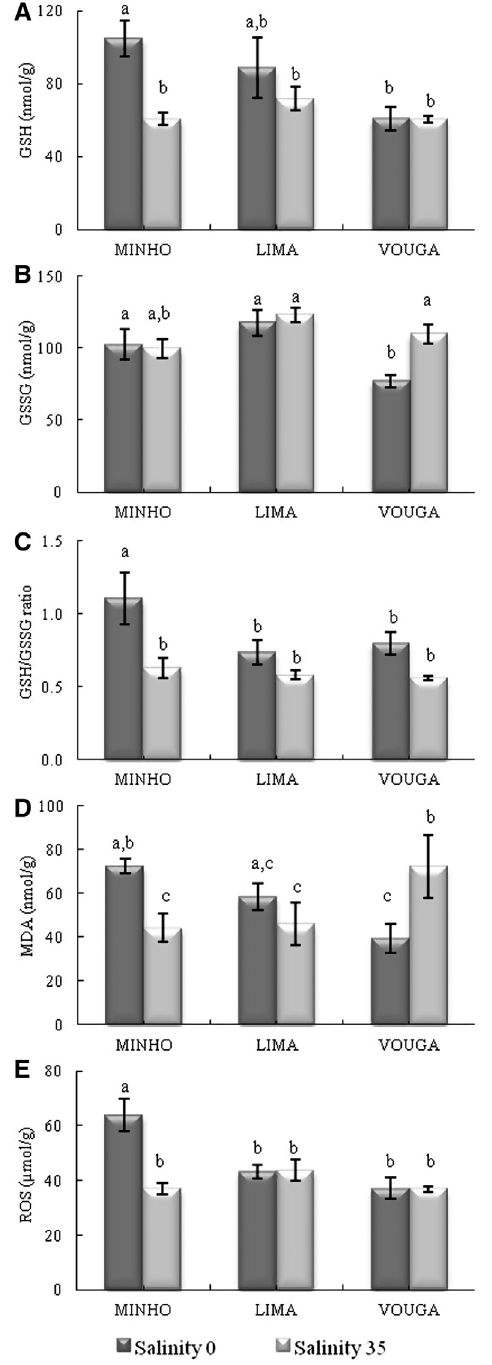
Figure 3: Mitochondrial contents in liver of (A) glutathione (GSH), (B) oxidized GSH (GSSG), (C) GSH/GSSG ratio, (D) malondialdehyde (MDA) and (E) reactive oxygen species (ROS) of sea lamprey juveniles kept for 30 days at 0 (gray bar) or gradually kept from 0 to 35 (white bar) salinity levels. Each bar represents the mean of five pools (8#) ± SEM. Bars marked with different letters are significantly different (p <